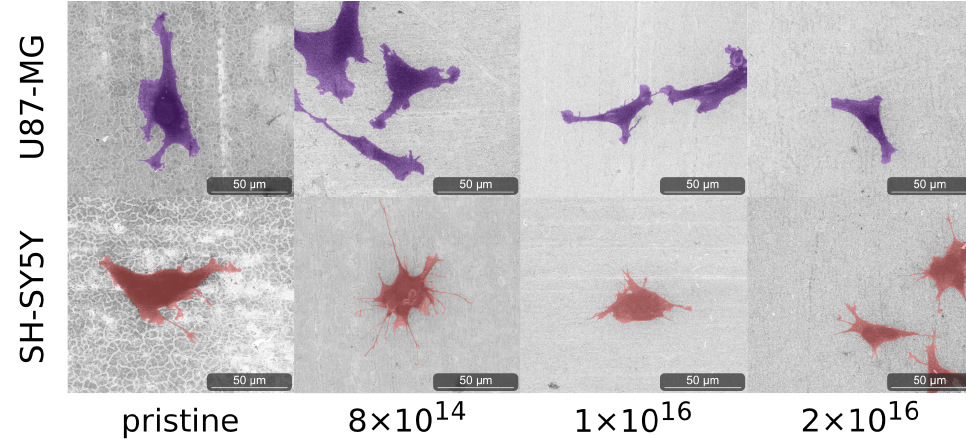
Figure 5. Images of analyzed cells acquired with ESEM after four days on the examined TNSs. To highlight the cells, we stained U87-MG purple and SH-SY5Y pink. Ion fluences are given in ions · cm − 2